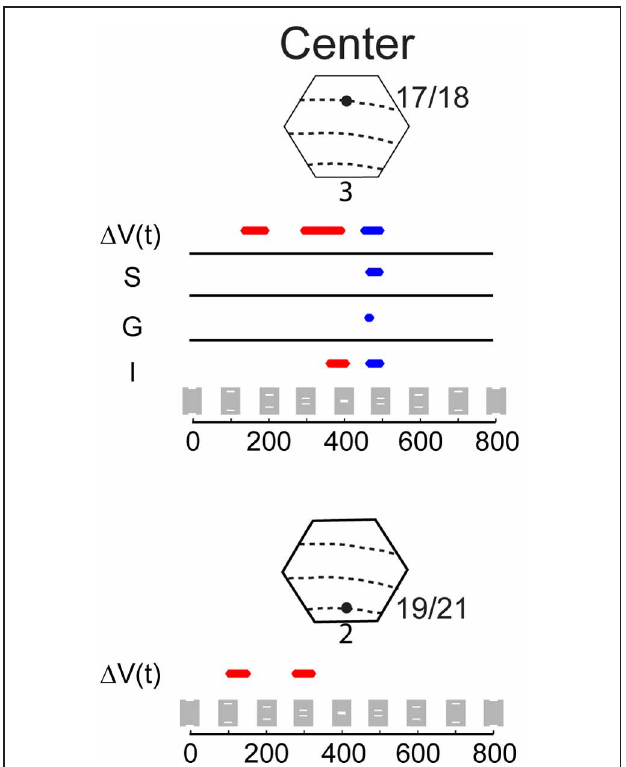
FIGURE 5 | Statistical comparison of the amplitude of the (cid:2) V ( t ) and MUA for the occlusion condition compared to the amplitude of the (cid:2) V ( t ) and MUA for the single bar conditions. The MUA was recorded from supragranular (S), granular (G), and infragranular (I) cortical layers at the cortical site for the center of field of view along the 17/18 border (Top) and for the (cid:3) V ( t ) at the corresponding cortical site along the 19/21 border (Bottom) . Epochs where the amplitude of the (cid:3) V ( t ) or the MUA during the occlusion condition is significantly greater ( p < 0 . 01) than the amplitude of (cid:3) V ( t ) or MUA of either of the two single bar conditions are shown in red, and epochs where the amplitude of (cid:3) V ( t ) and MUA in the occlusion condition is significantly less than the amplitude of responding to the single bar conditions are shown in blue ( p < 0 . 01 see Materials and Methods). Note that the (cid:3) V ( t ) and MUA in the time window 392 to 460ms was not significantly different from that of a single bar ( p > 0 . 2).